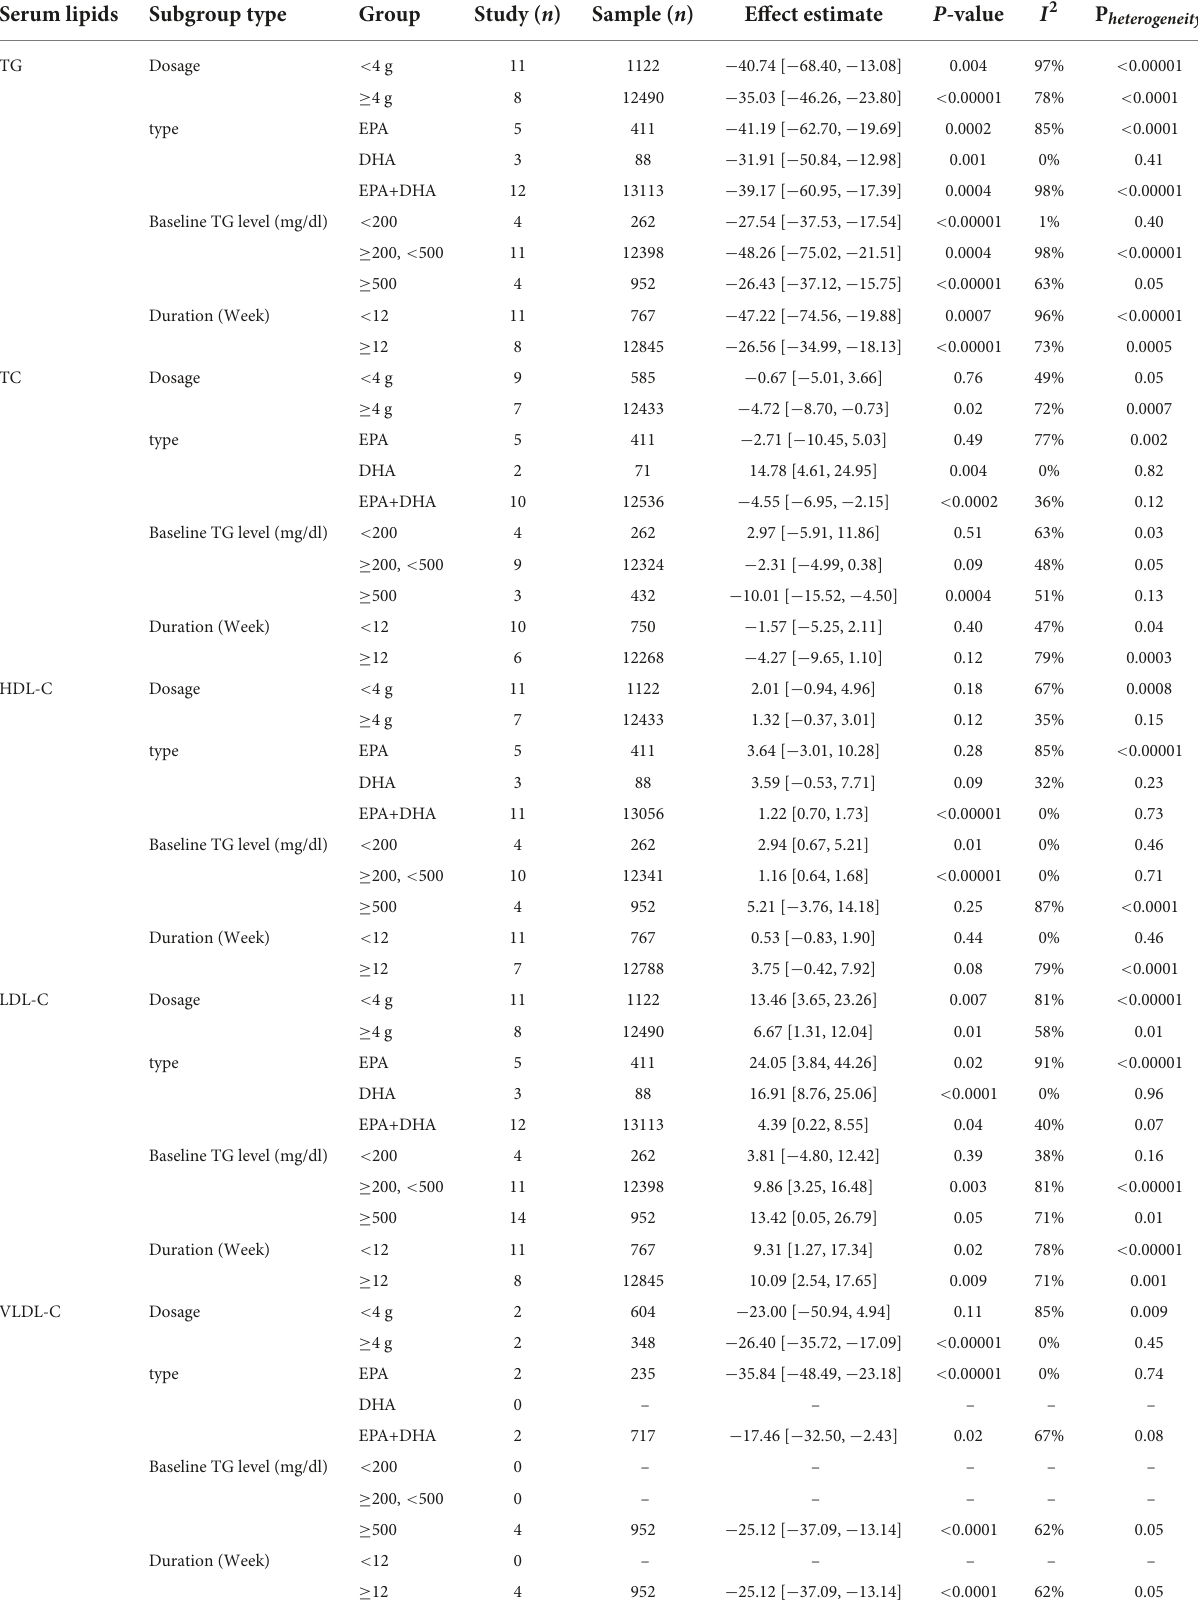
TABLE 2 Subgroup analysis of the effect of OM3-FA monotherapy on lipid profile. Serum